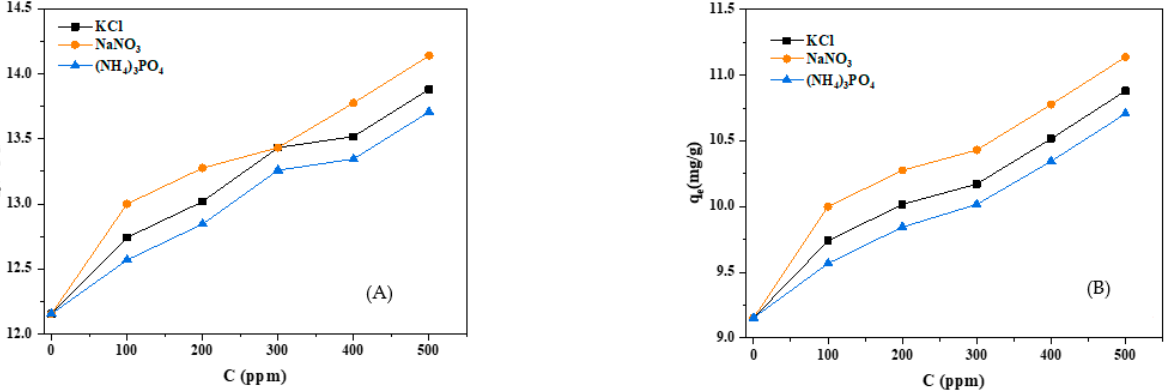
Figure 8. Effect of interference of inorganic salts on ( A ) L. Clay, ( B ) Y. Clay; Conditions: pH = 2, V = 20 mL, C = 12 mg/L.